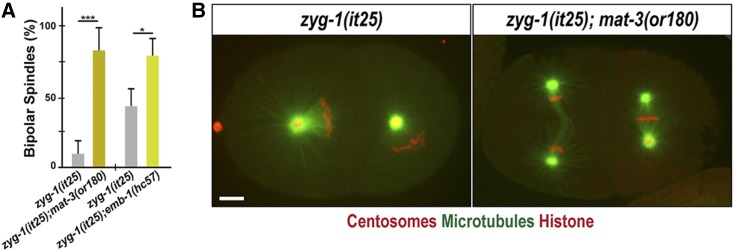
Inactivating the APC/C restores bipolar spindle formation to zyg-1(it25). (A) Quantification of bipolar spindle formation during the second cell cycle. At 24°, zyg-1(it25); mat-3(or180) double mutants assembled bipolar spindles at a significantly higher percentage (81.8 ± 14.3%, n = 78, P < 0.001) than zyg-1(it25) embryos (9.1 ± 8.8%, n = 144). At 22.5°, there is an increase in bipolar spindle formation in zyg-1(it25); emb-1(hc57) double mutants (79.1 ± 12.4%, n = 228, P = 0.03), compared to zyg-1(it25) single mutants (45.5 ± 11.9%, n = 238). n is the number of blastomeres. * P < 0.05, *** P < 0.001 (two-tailed t-test). (B) Still images of embryos expressing GFP::β-tubulin, mCherry::γ-tubulin (centrosome marker) and mCherry::histone raised at 24° illustrate monopolar spindle formation in the zyg-1(it25) embryo, and bipolar spindle formation in the zyg-1(it25); mat-3(or180) double-mutant embryo. Bar, 5 μm.